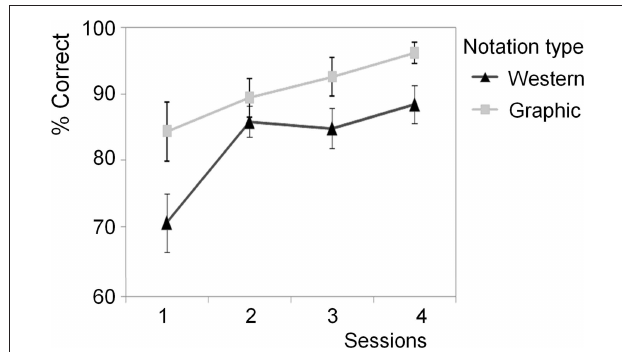
Figure 4 | improvement in melodic manipulation performance for the western and graphic notation groups over sessions